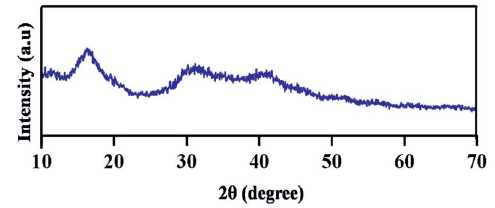
Fig. 3. XRD spectrum of Chitosan nanoparticles Fig. 4. Zone of Inhibition of chitosan nanoparticles against tested bacteria Bacillus spp.